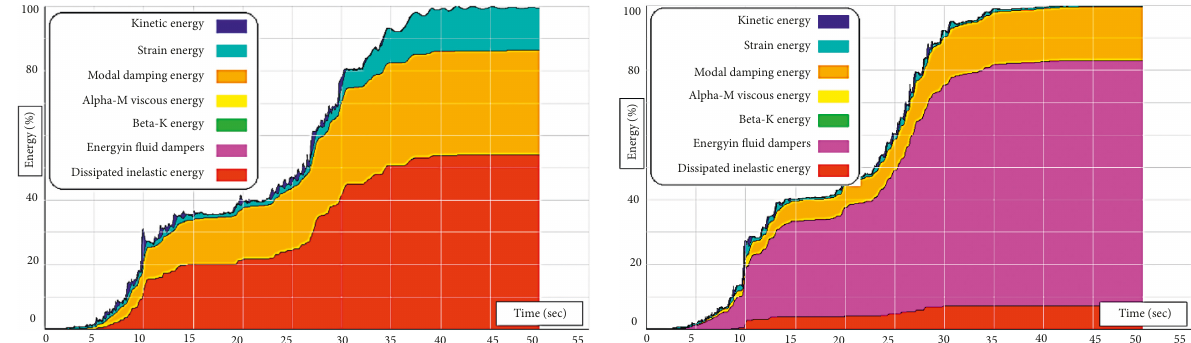
Figure 7: 8-story frame under record near Landers without and with dampers.